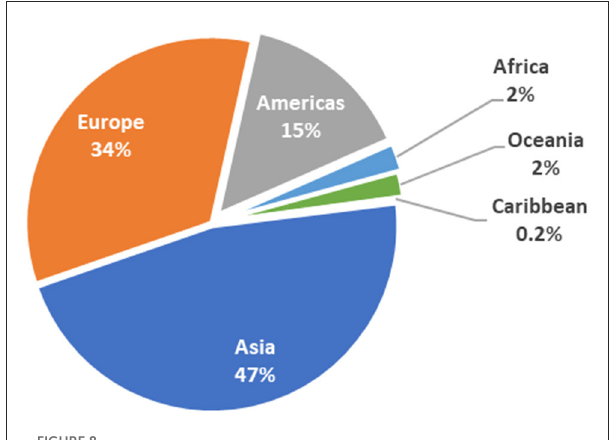
FIGURE8 Contribution to sustainable supply chain management literature per